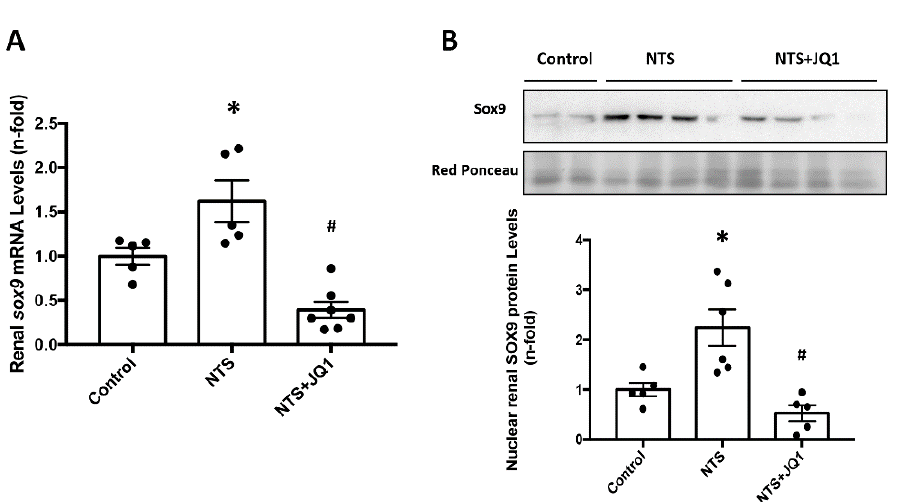
Figure 5. JQ1 reduces renal Sox-9 gene overexpression and blocks SOX-9 nuclear translocation in experimental nephrotoxic nephritis. Mice were treated daily with JQ1 (100 mg/kg/day) or vehicle for 10 days, starting before the first NTS injection. ( A ) RNA was isolated from frozen whole kidney samples, and Sox-9 gene expression levels were evaluated by real-time qPCR. ( B ) Protein levels of SOX9 were quantified by Western blot in nuclear kidney extracts. The figure shows representative blots where Red ponceau was used as a loading control. Data are expressed as the mean ± SEM of 5–7 animals per group. * p < 0.05 vs. control; # p < 0.05 vs. NTS-injected mice.